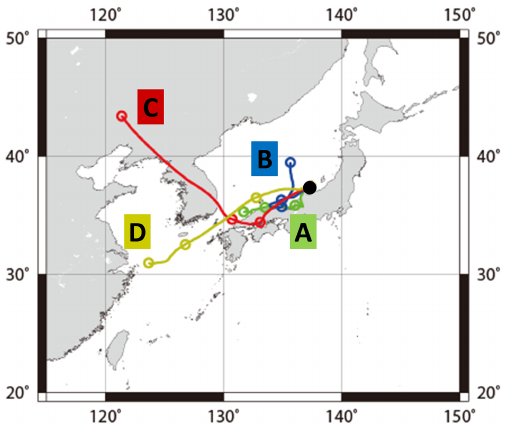
Figure 4. The 72h horizontal backward trajectories for air masses reaching the observation site at 500 m a.s.l. during sampling periods A–D. Open dots along the trajectory represent the position of the air mass every 24h backward from the arrival